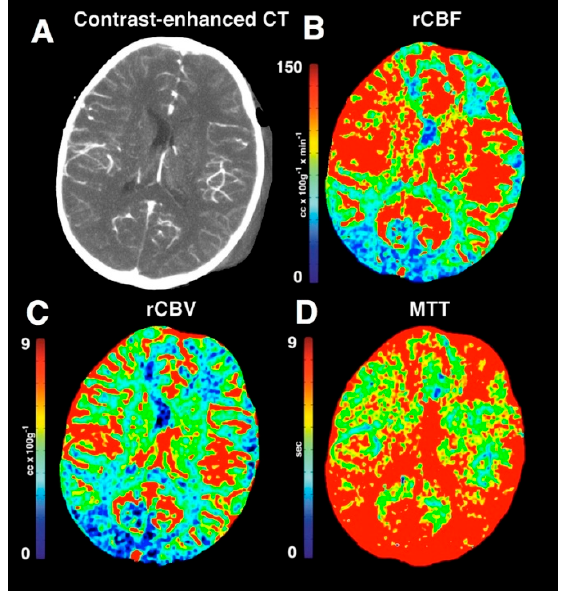
of the rCBF in the right temporal lobe. Reprinted with permission from [35].